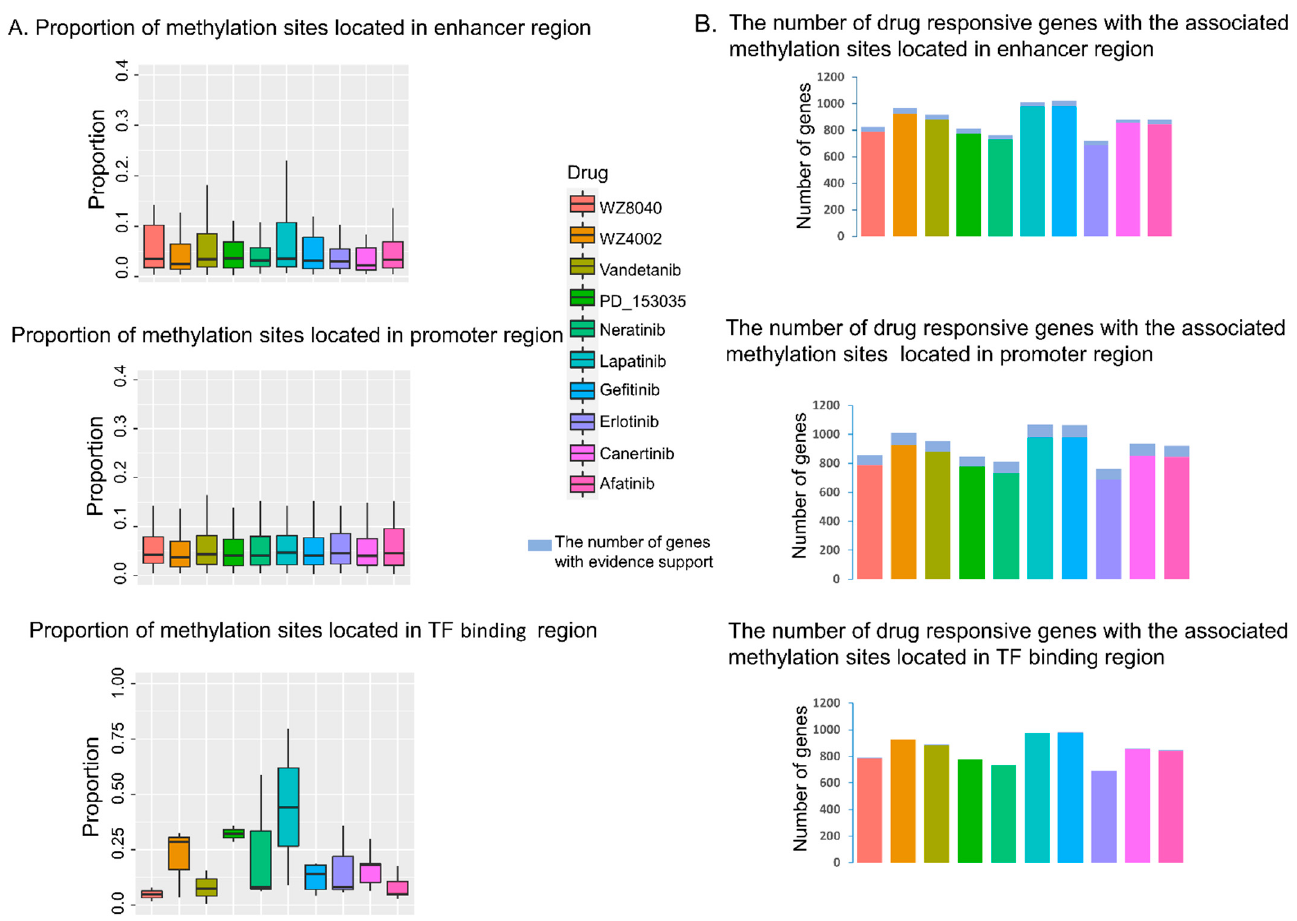
Figure 4. Location information of methylation sites related to EGFR inhibitor response. ( A ) The proportion of predicted methylation sites located in enhancer, promoter, or TF binding regions. ( B ) The light blue bar represents the number of responsive genes supported by evidence; that is, the methylation sites closely associated with the responsive genes were located in important regulatory regions (enhancer, promoter, transcription factor binding) for each of the 10 EGFR inhibitors, respectively.